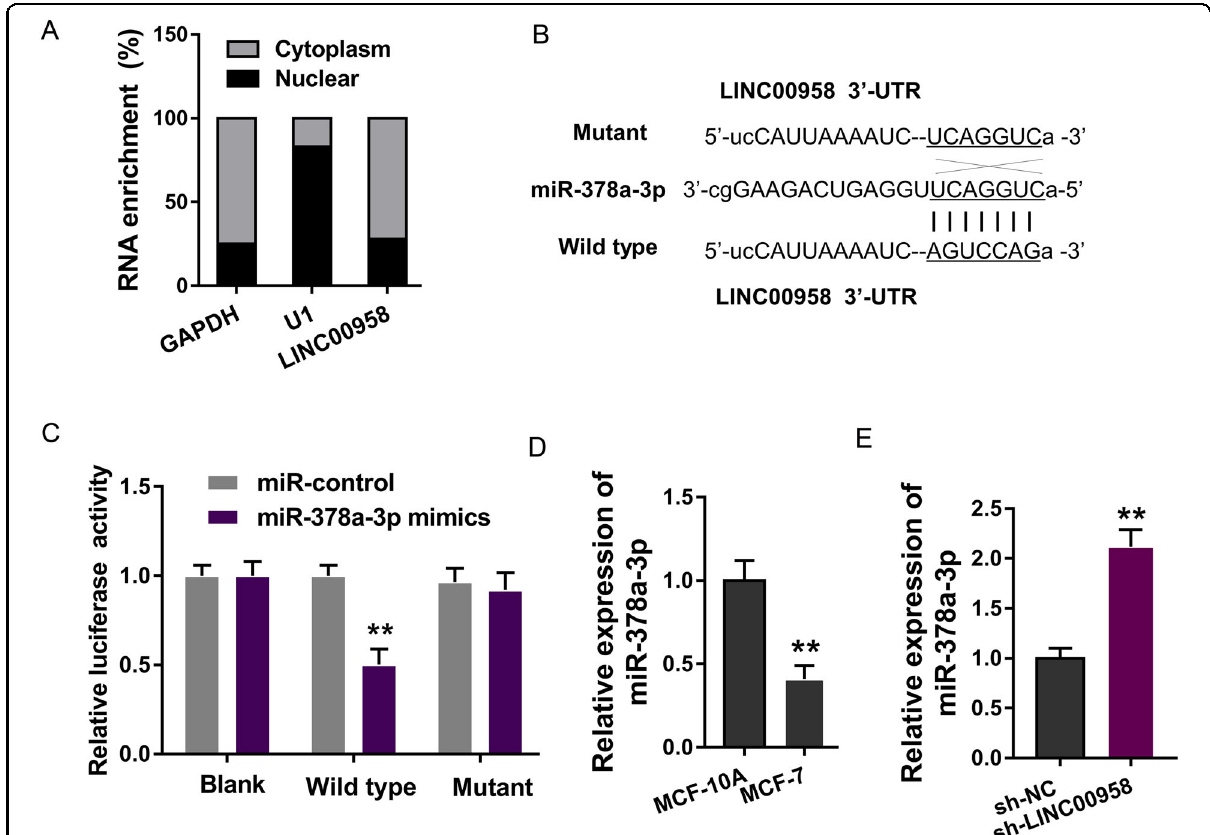
Fig. 4 LINC00958 targeted miR-378a-3p. A Subcellular analysis found that LINC00958 was predominantly located in the cytoplasm of MCF-7 cells. B Bioinformatics predictive tools found targeting miR-378a-3p and LINC00958. C Luciferase reporter assay found that miR-378a-3p mimics could directly combine with wild-type LINC00958. D RT-PCR showed miR-378a-3p expression in BC cells (MCF-7) compared to normal cells (MCF-10A). E RT- PCR showed miR-378a-3p expression in MCF-7 cells transfected with LINC00958 knockdown. ** p < 0.01 was considered as signi fi